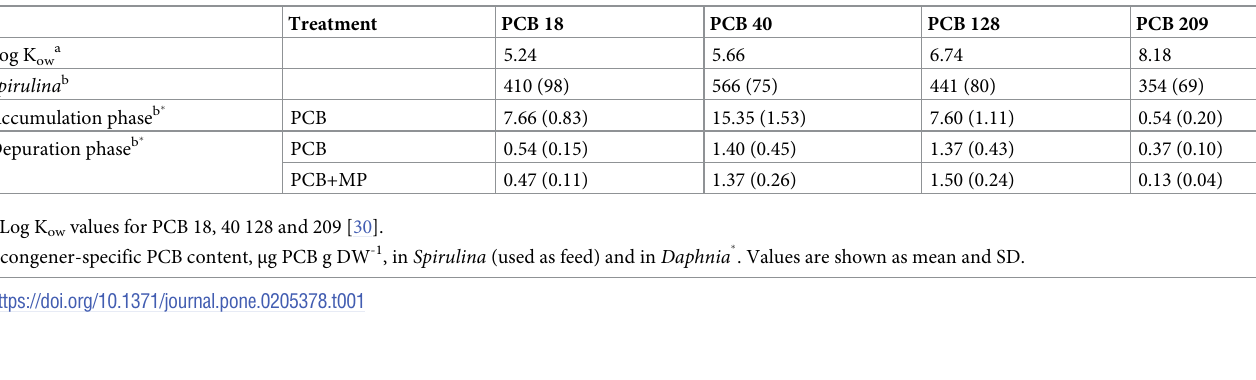
Table 1. Log K ow values and PCB concentrations in feed and Daphnia observed at the end of the accumulation phase and after